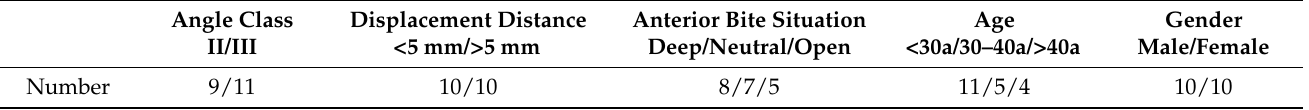
Table 1. Patient’s